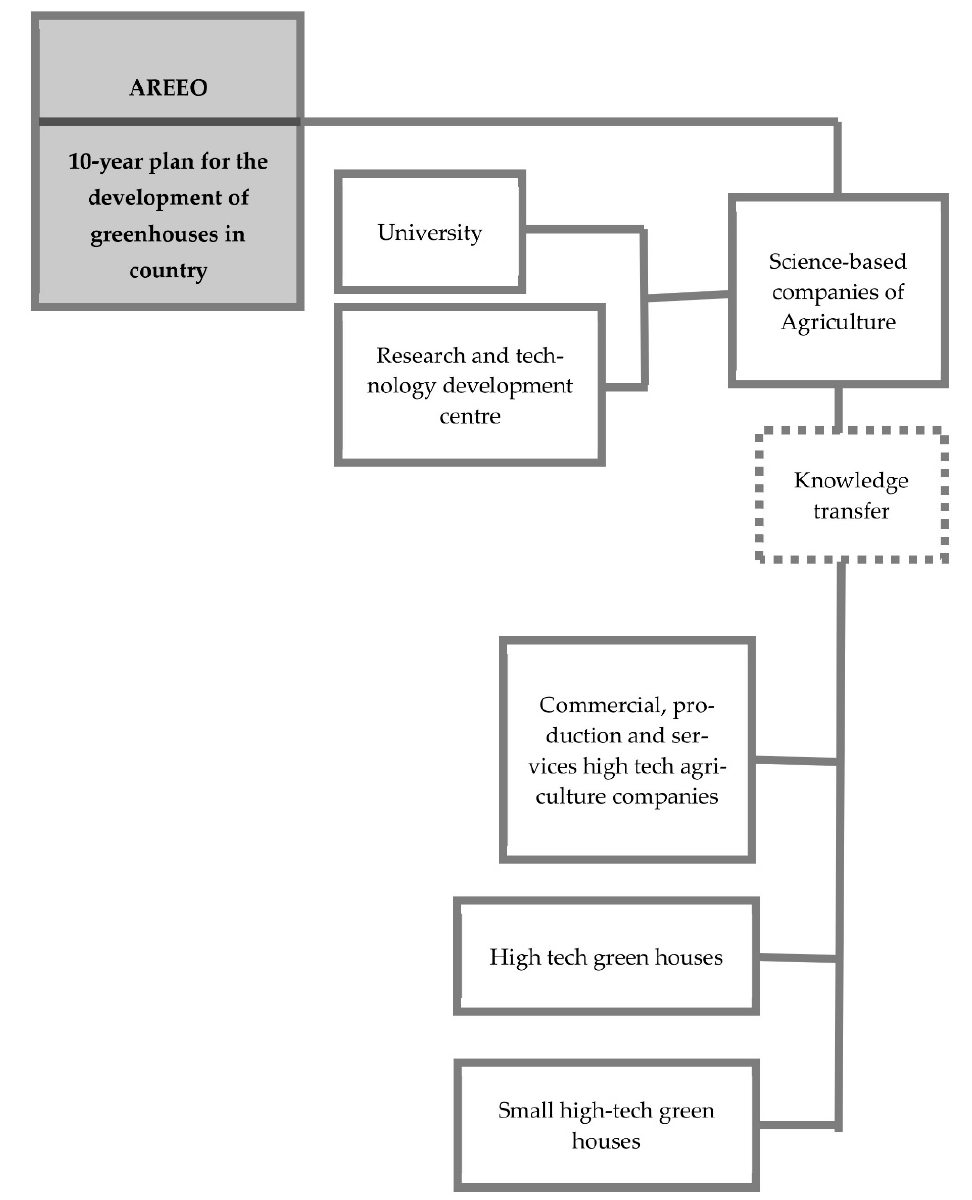
Figure 9. The second re-entanglement step.